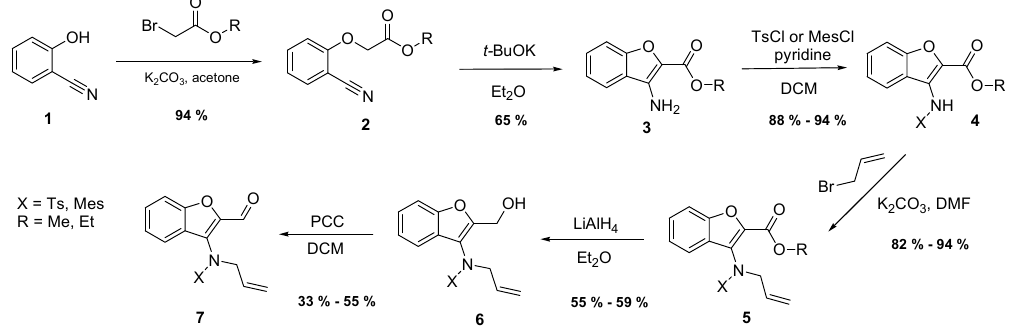
Scheme 3. Reaction path leading to the synthesis of the key starting molecule N -allyl- N